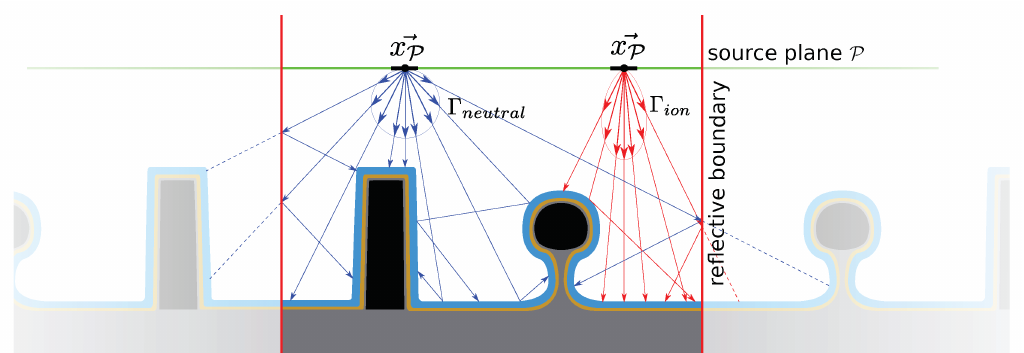
Figure 2. Schematic depiction of particle rays being traced from the source plane to the surface. The particles describe either neutral atoms or molecules (blue) or ions (red), governed by the source distribution fluxes Γ n and Γ i , respectively. The fluxes define the distribution of particle directions and energies. Specular reflections are shown for ions, and diffuse reflections for neutral